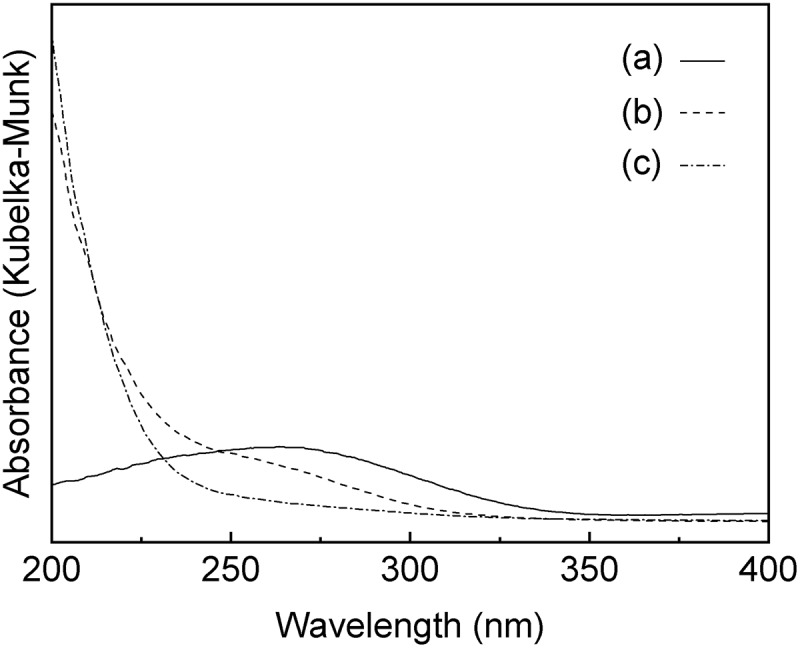
UV-vis spectra of a mixture of the amorphous Sn(OH)4 powder and fumed silica for the Si/Sn molar ratio of 20; (a) before the mechanochemical treatment; (b) after grinding for 12 h, g(SiO2–SnO2)12; (c) after grinding for 24 h, g(SiO2–SnO2)24.